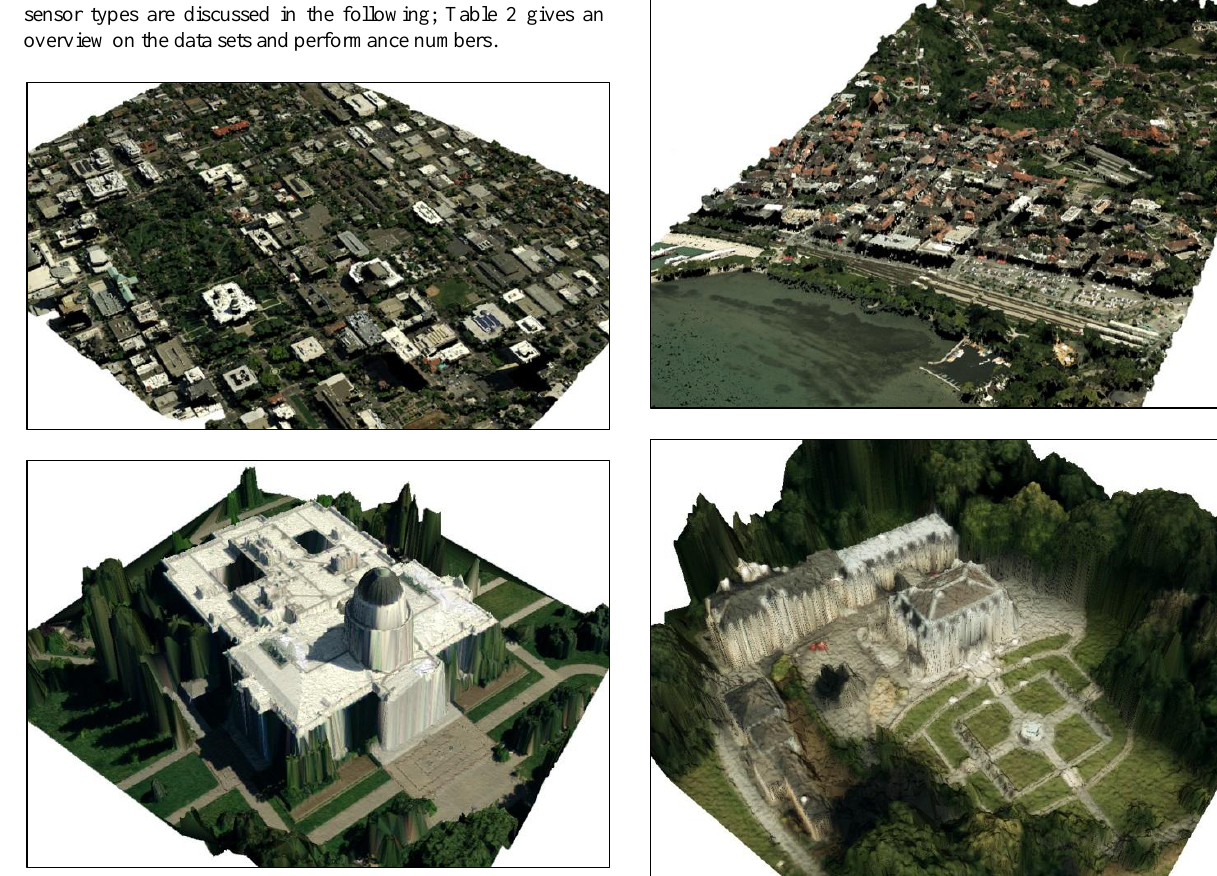
Figure 6: RGB colored info cloud derived from RCD30 data in Bregenz, Austria (top) and enlarged TIN view